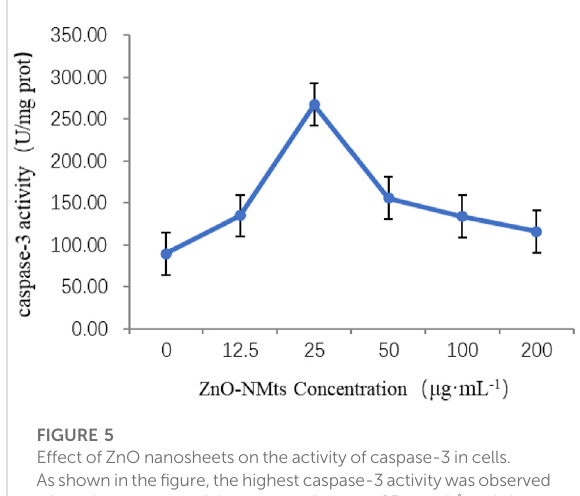
FIGURE 5 EffectofZnOnanosheetsontheactivityofcaspase-3incells. Asshowninthe fi gure,thehighestcaspase-3activitywasobserved when the nanomaterial concentration was 25 μ g ml − 1 and then decreased with the increasing concentration.